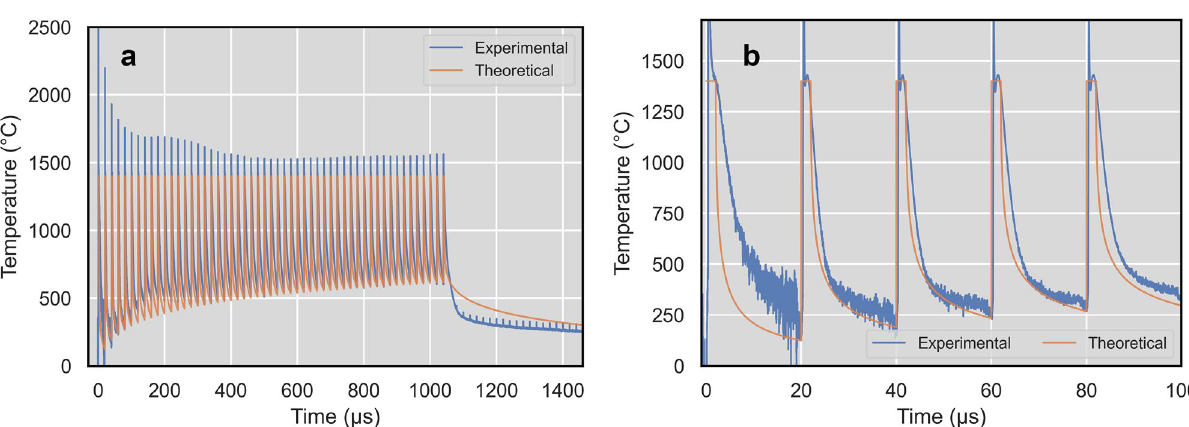
Figure 6. Temperature values during the multi-beam laser LIPSS formation for laser fluence of 0.12 J/cm 2 : ( a ) full temperature–time history of LIPSS formation (blue line experimental measurements, red line—theoretical approximation), ( b ) zoom of temperature–time history for the first five laser